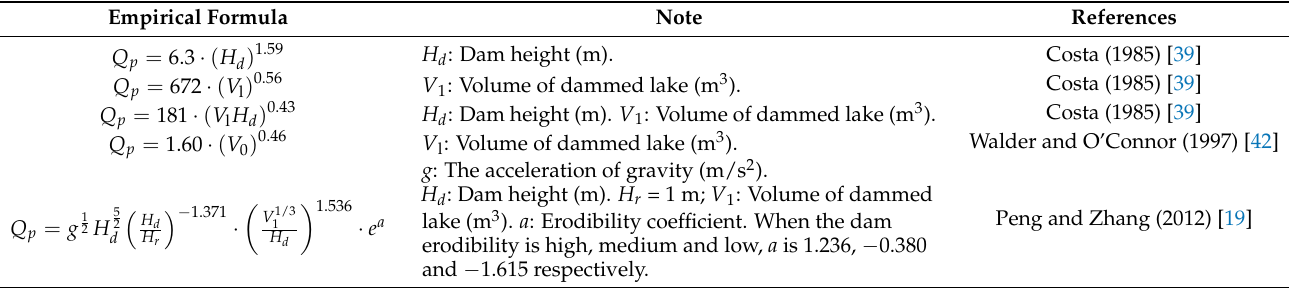
Table 2. Empirical formula for peak discharge of landslide dam burst flood. Empirical